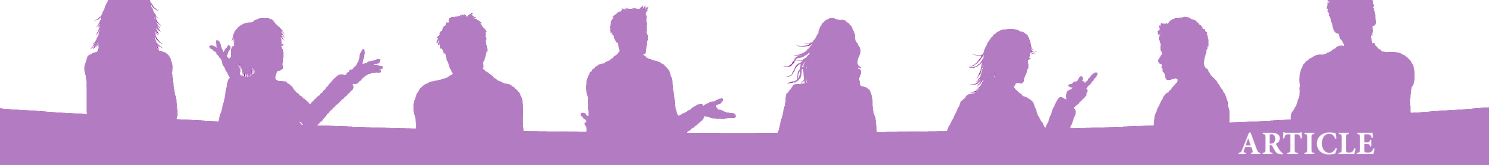
Sociodemographic